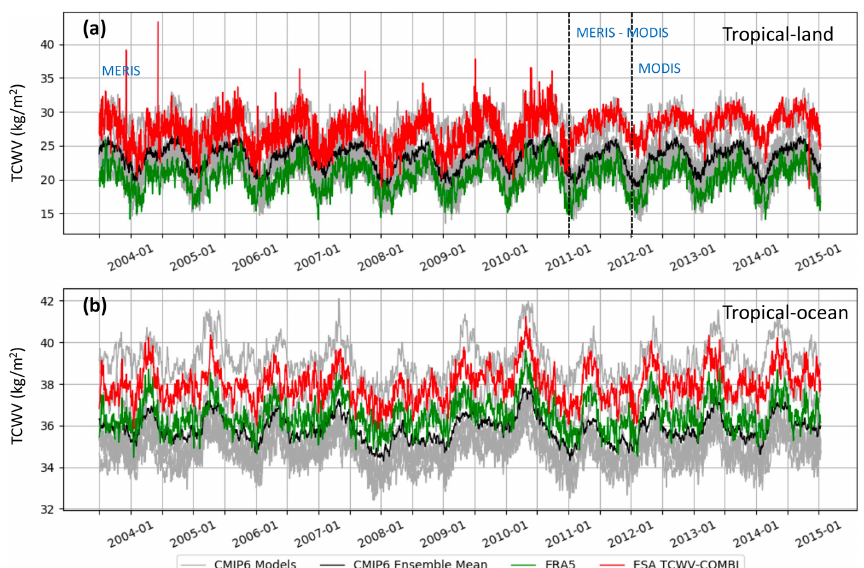
Figure 3. Time series of daily mean TCWV in the tropics (30 ◦ S–30 ◦ N) over (a) land areas under clear-sky conditions and (b) ocean areas except for heavy precipitation (see details in Sect. 2). The time series cover the period July 2003–December 2014. The grey lines denote the individual CMIP6 models, while the black line represents their ensemble mean. The green line represents ERA5, and the red line is the ESA CCI_WV TCWV-COMBI.